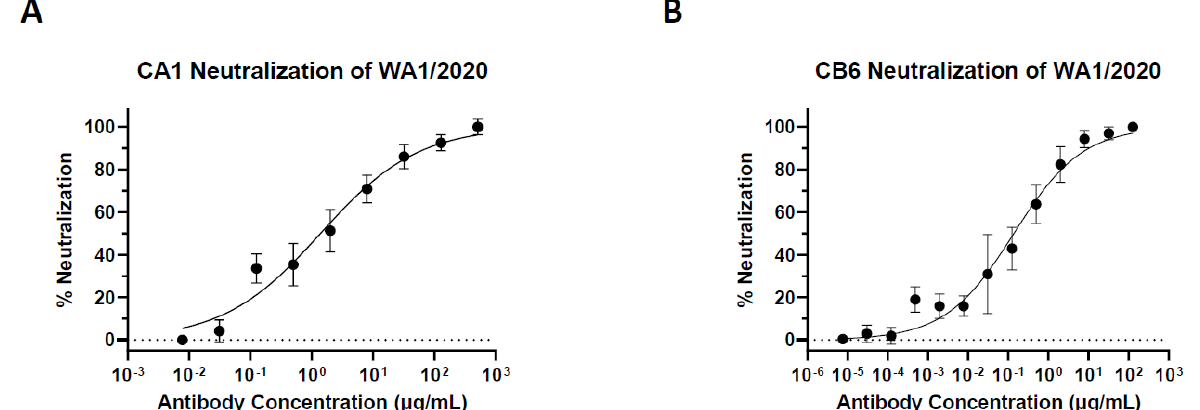
Figure 5. Neutralization of SARS-CoV-2 by plant-made CA1 and CB6. Serially diluted plant-made CA1 ( A ) or CB6 ( B ) were mixed with SARS-CoV-2 before adding to Vero E6 cells in a 96-well plate for 24 h. Cells were fixed, permeabilized, and stained for SARS-CoV-2 S protein. Foci were quantified, percent neutralization was calculated, and IC 50 was determined. Error bars represent SD and at least two independent experiments were performed with technical triplicates.